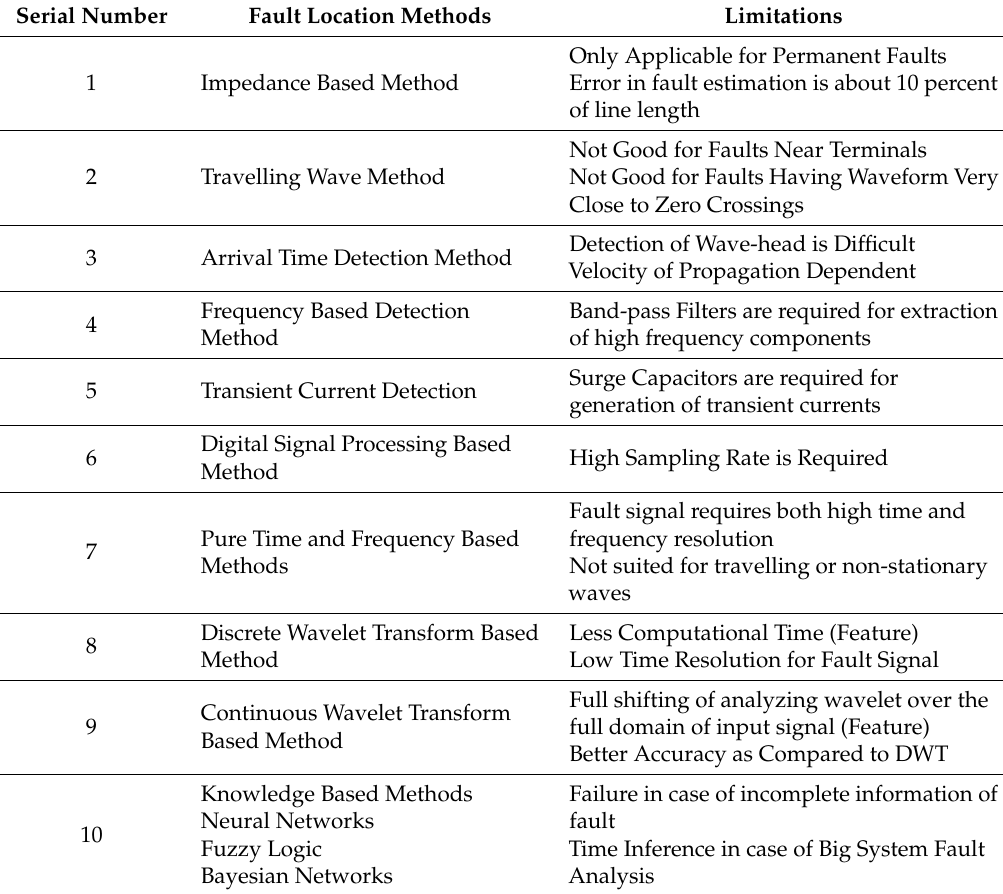
Table 3. Fault location methods and their